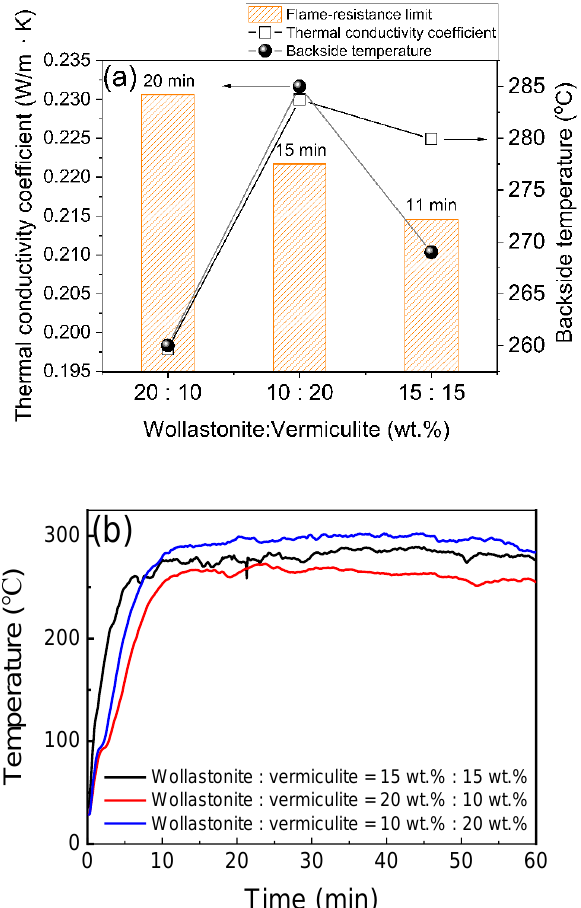
Figure 4. ( a ) Thermal conductivity, backside temperature for steel substrate, and flame-resistance limit; and ( b ) flame-resistance rating of the MKPCs with different weight ratios of wollastonite to vermiculite. (magnesia/KH 2 PO 4 molar ratio = 4).